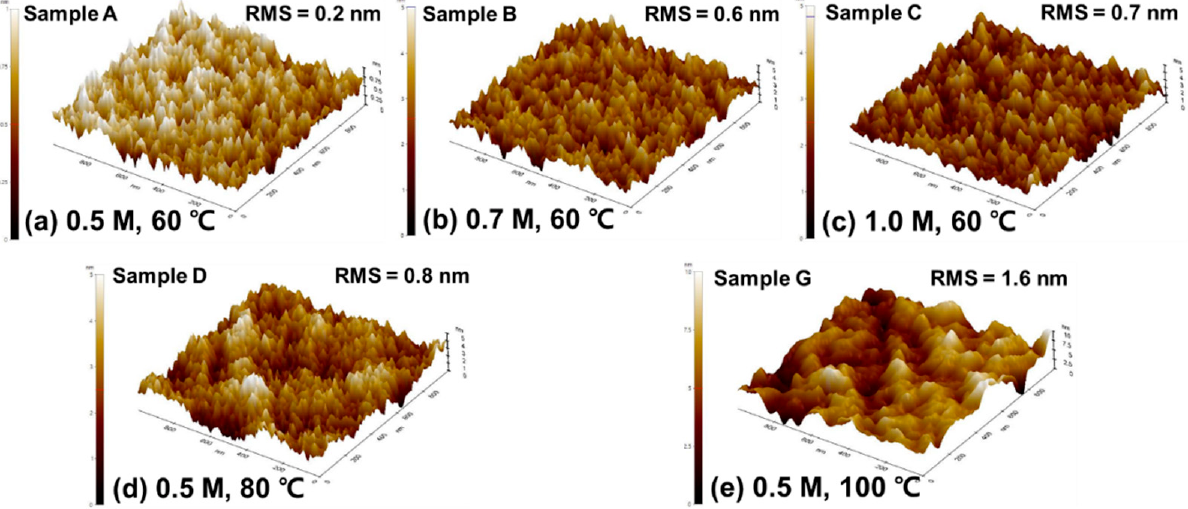
Figure 5. 3D AFM images of the as-deposited β -Ga2O3 thin films at different molar concentrations and drying temperatures. ( a ) 0.5 M, 60 °C, ( b ) 0.7 M, 60 °C, ( c ) 1.0 M, 60 °C, ( d ) 0.5 M, 80 °C, and ( e ) 0.5 M, 100 °C